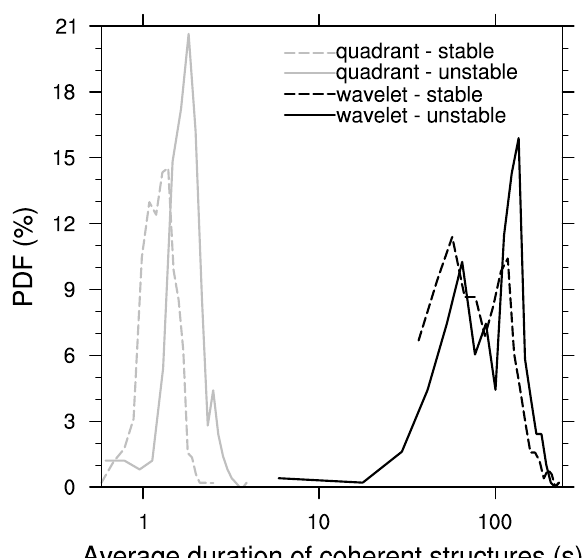
Fig. 5. Probability distribution function of the number of coher- Figure 5. Probability distribution function of the number of coherent structures per 30-­‐823 ent structures per 30-min for the Q-H (gray) and wavelet methods minute for the Q-­‐H (gray) and wavelet methods (black) under stable (dashed lines) and 824 (black) under stable (dashed lines) and unstable (solid lines) condi- tions. unstable (solid lines) conditions. 825